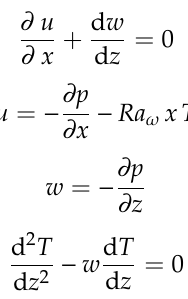
Figure 2. A rotating rectangular porous domain heated from above, cooled from below, and insulated